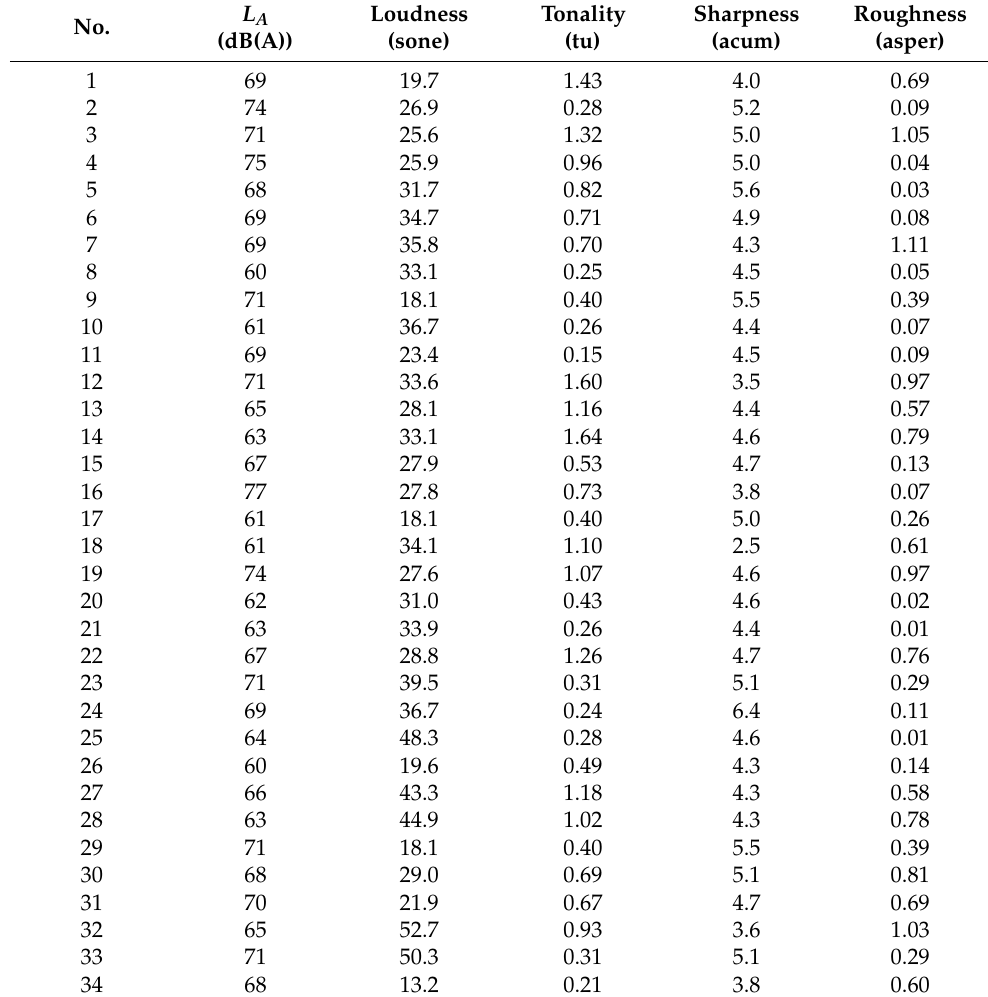
Table 2. Parameters corresponding to each item in the 34 representative samples.